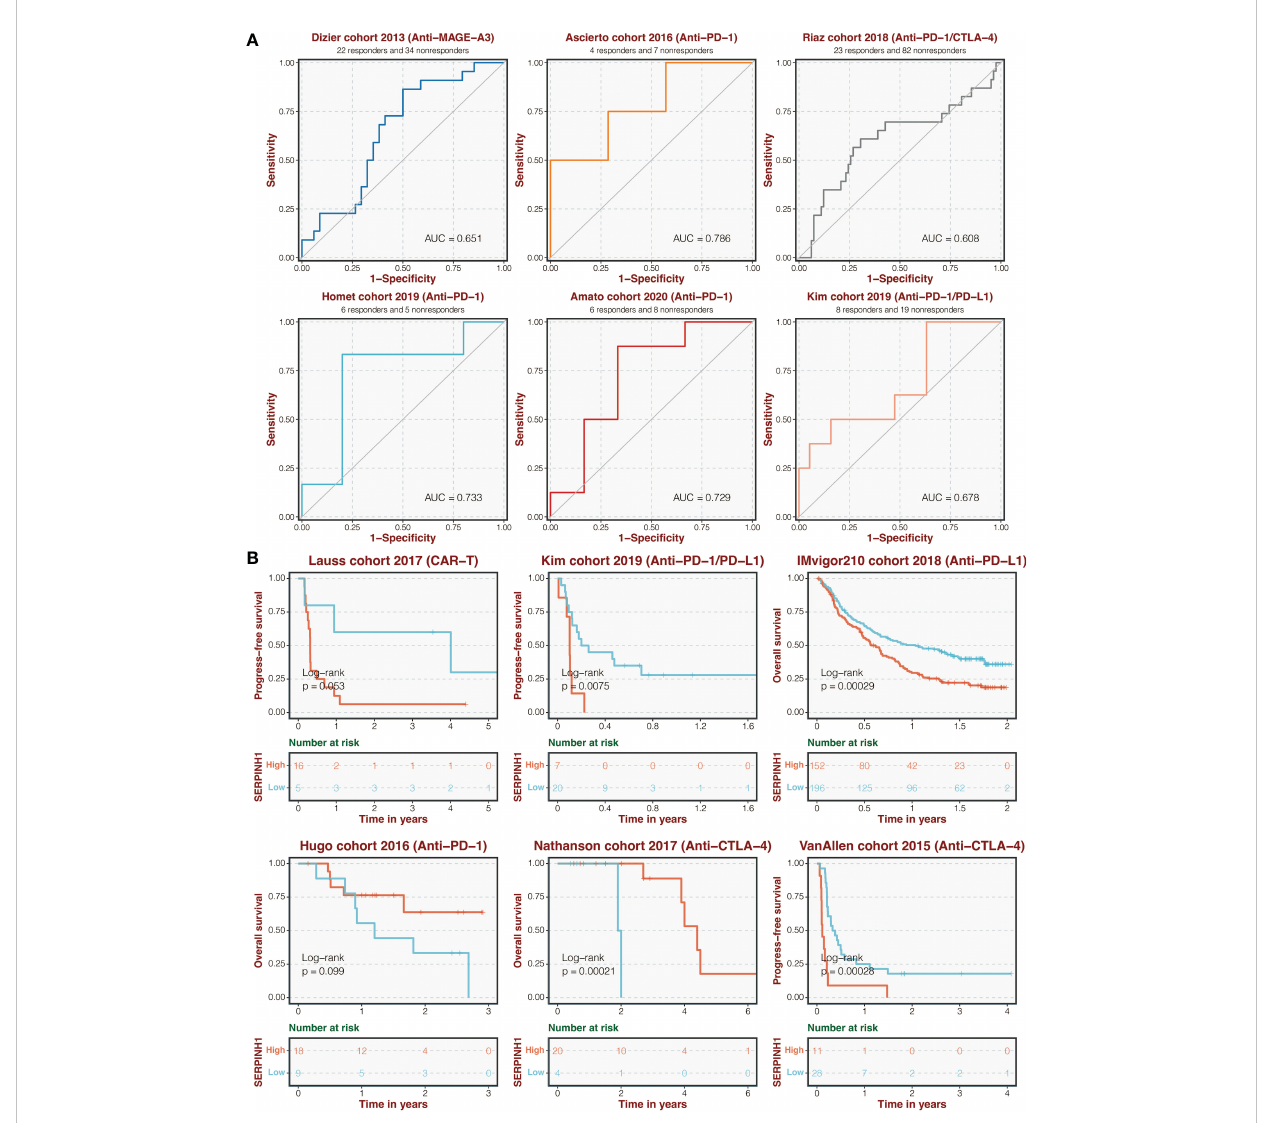
FIGURE 3 Immunotherapy prediction of SERPINH1. (A) ROC regarding the sensitivity of SERPINH1 in immunotherapy prediction in six immunotherapy cohorts. (B) Survival curves of the two SERPINH1-strati fi ed groups in six immunotherapy